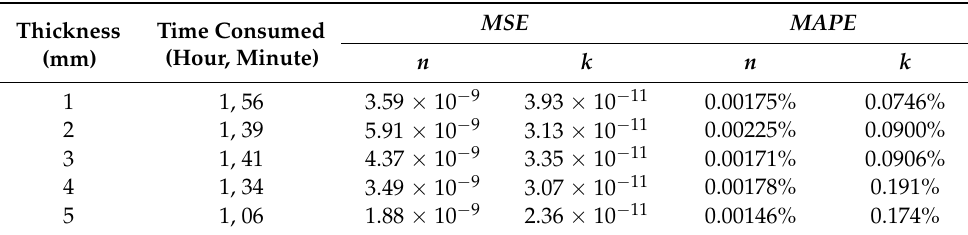
Table 1. Training time, MSE and MAPE values of the 4-layer network for material with different thick-